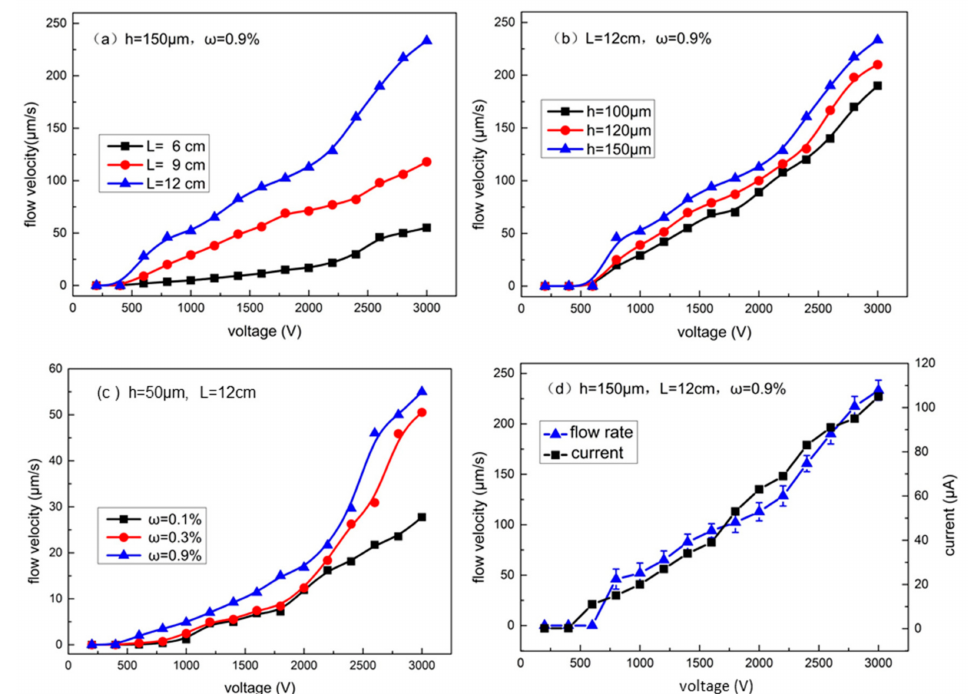
Figure 5. Experimental results of parametric studies. ( a ) Flow velocity as a function of voltage applied with different pumping zone channel lengths (the non-pumping channel was 5 mm long. All channels were 50 µ m high); ( b ) Flow velocity as a function of voltage with different channel heights; ( c ) Flow velocity as a function of voltage with different saline solution concentration ( ω ); ( d ) Flow velocity and the average current as functions of different voltages applied to the same